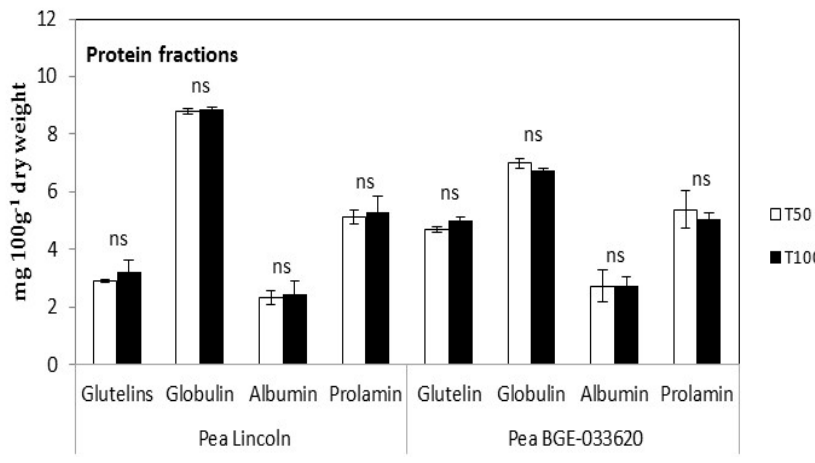
Figure 5. Protein fractions in edible parts of Lincoln and BGE-033620 peas grown under normal (T100) and sustained deficit (T50) fertigation tested under protected cultivation conditions. “ns” indicates non-significant differences between treatments (T50 and T100) for each cultivar (ANOVA followed by Tukey’s multiple range test).